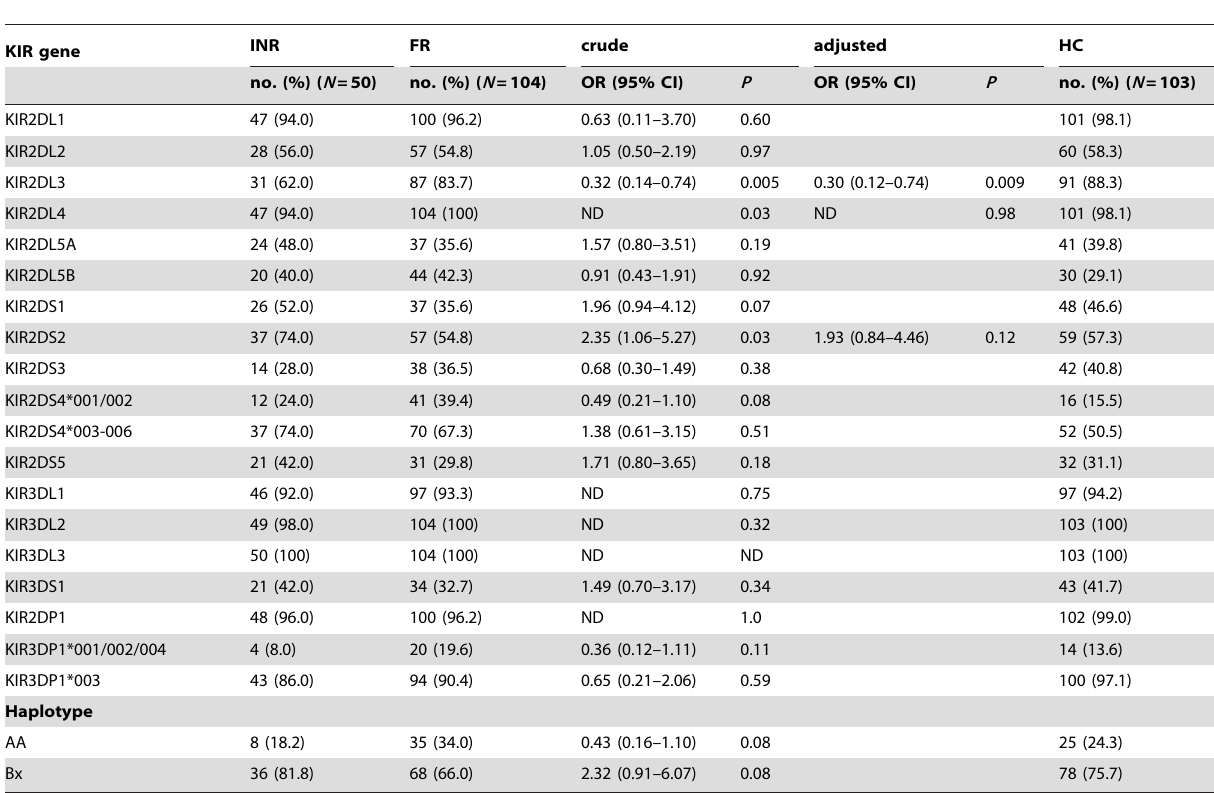
Table 2. KIR alleles and haplotype frequencies distribution in full responders (FR), immunological non responders (INR), and in healthy controls as reference (HC). Analysis is adjusted for nadir CD4 + T-cell counts.